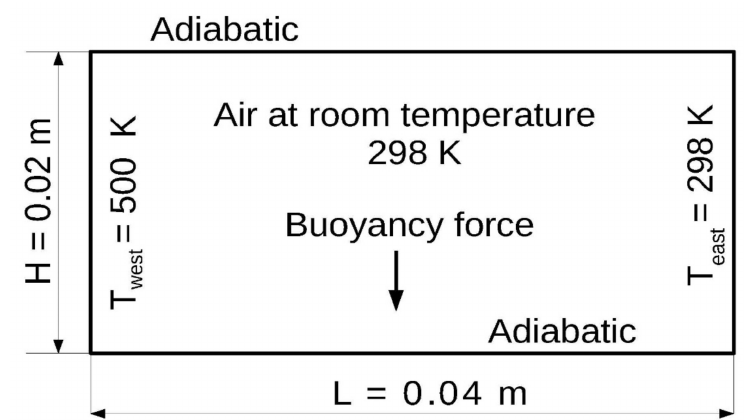
Figure 3. Schematic diagram of the differentially heated